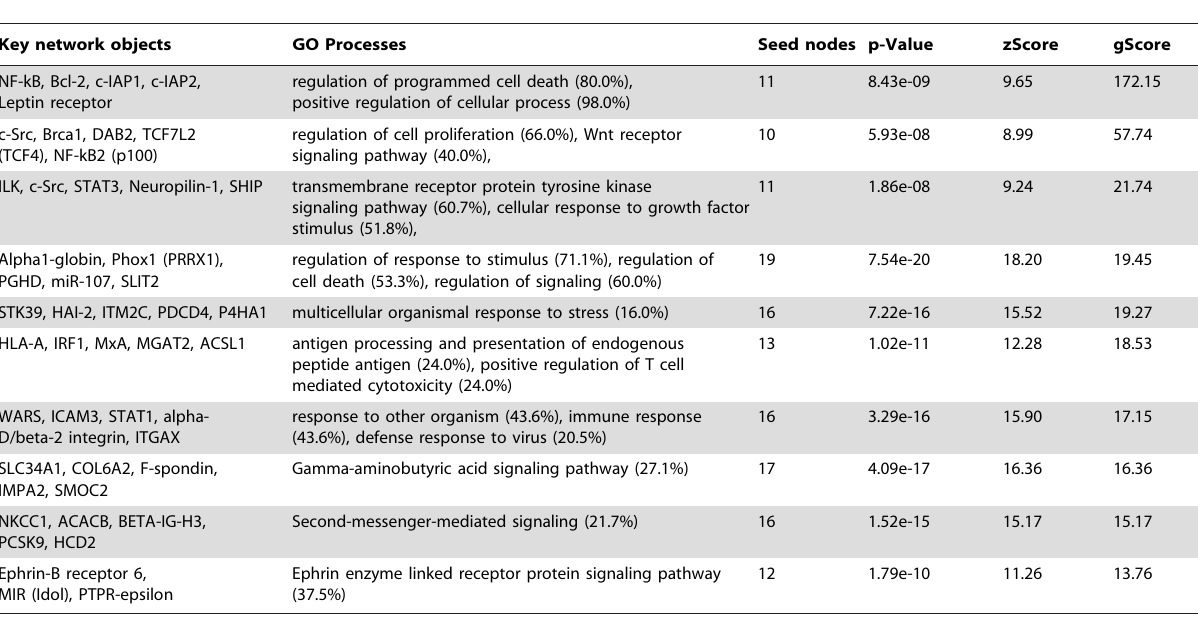
Table 3. Transcriptional modulation of biological networks in chronic HCV infection.